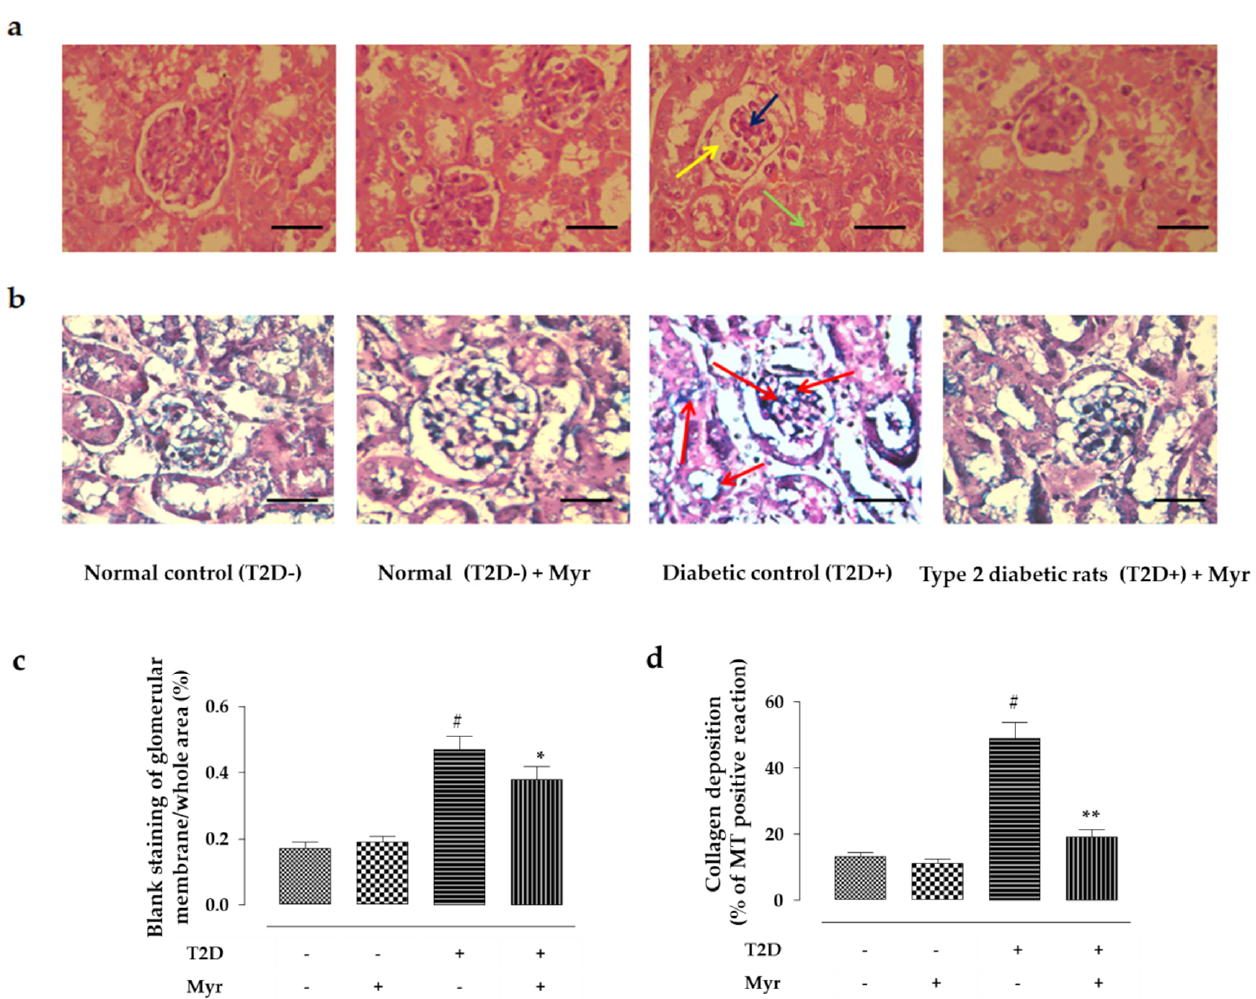
Figure 13. The effects of Myr on the histological structures of the kidneys of T2D rats. ( a ) H&E-stained sections of mice kidneys. ( b ) The MT-stained sections of mice kidneys. ( c ) The widening of capsular space is shown as a percentage of the blank staining of glomerular membrane compared to the whole area of the H&E-stained photomicrograph. ( d ) Histo-quantification of collagen deposition in MT-stained kidney sections. T2D rats showed thickening of Bowman’s capsules (yellow arrow), glomerular hypercellularity (blue arrow), cloudy appearance of tubules (green arrow), and collagen deposition (red arrows). Data are represented as the mean ± SD, n = 6 × 5. Five randomly selected portions containing a glomerulus from kidney section of each mouse were chosen for the quantification. # Values significantly ( p < 0.01) differed from the normal control (T2D − ) group. * Values significantly ( p < 0.05) differed from the diabetic control (T2D+) group. ** Values significantly ( p < 0.01) differed from the diabetic control (T2D+) group.